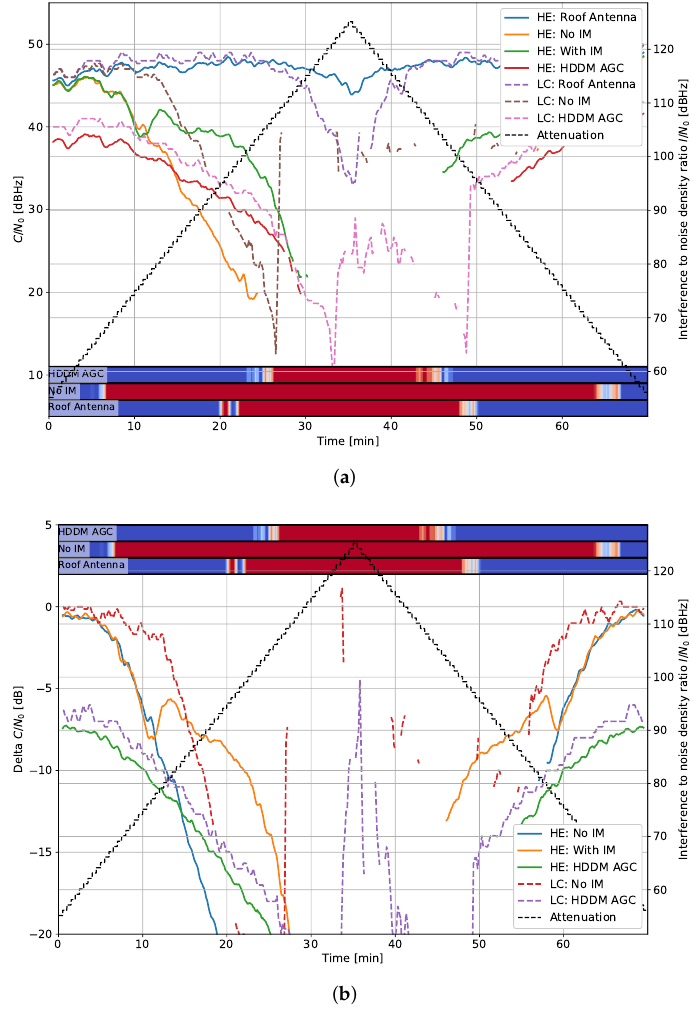
Figure 7. Interference #2 (fast chirp): 10 MHz bandwidth and chirp repetition rate of 10µs. ( a ) C / N 0 for the highest elevation satellite. ( b ) Delta C / N 0 for the highest elevation satellite. A bar indicates whether interference is detected per device in each plot. Blue indicates no detection, and red designates interference is present. Figure 7 detects interference from an I / N 0 of about 65 dBHz for the “No IM” case. It also detects interference signals in the roof antenna, highlighting the isolation issue again. The detection is less in the HDDM-AGC case. It can be due partly to the IM but also to the AGC that normalizes the spectrum: the detector—amongst other methods—employs an energy detection that requires tuning. The AGC partially counters it, resulting in fewer detections. Nevertheless, the HDDM-AGC still results in some interference detection at high I / N 0